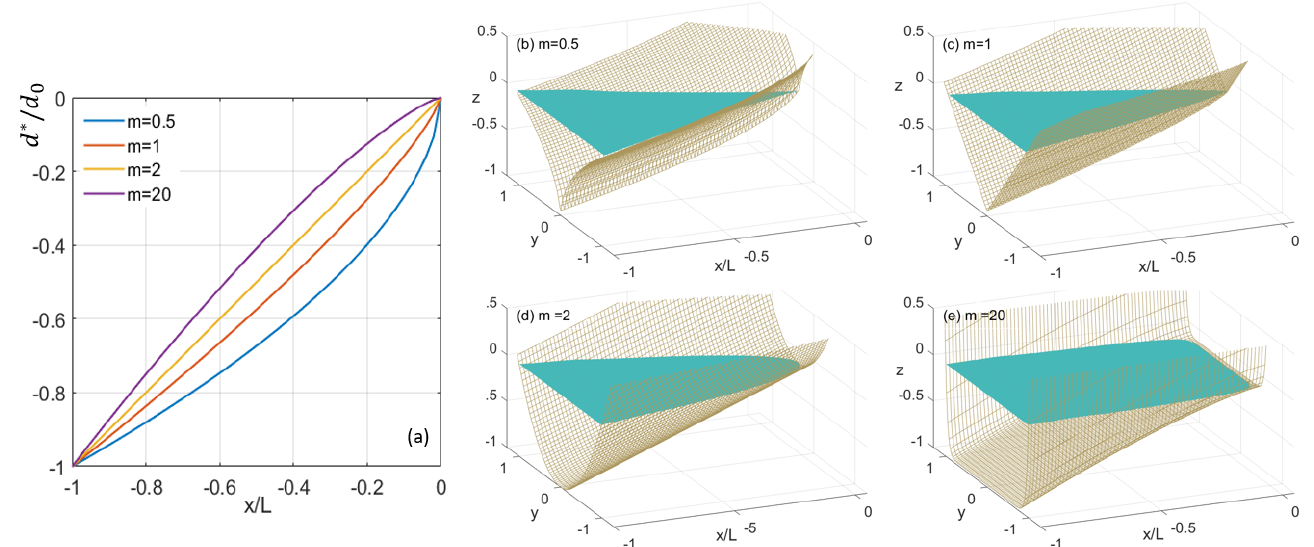
Figure 6. ( a ) Illustration of the non-constant sloping bed x 4 m / ( 3 m + 2 ) in (16); and ( b – e ) the 3D sketches of non-reflecting bay B ∗ = m for m